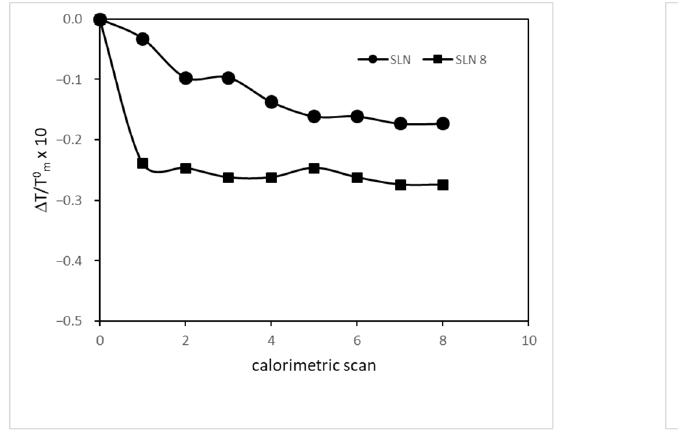
Figure 6. Calorimetric curves, in heating mode, of MLV put in contact with SLN 8 at increasing incubation time. There are 68 min between one scan and the next.